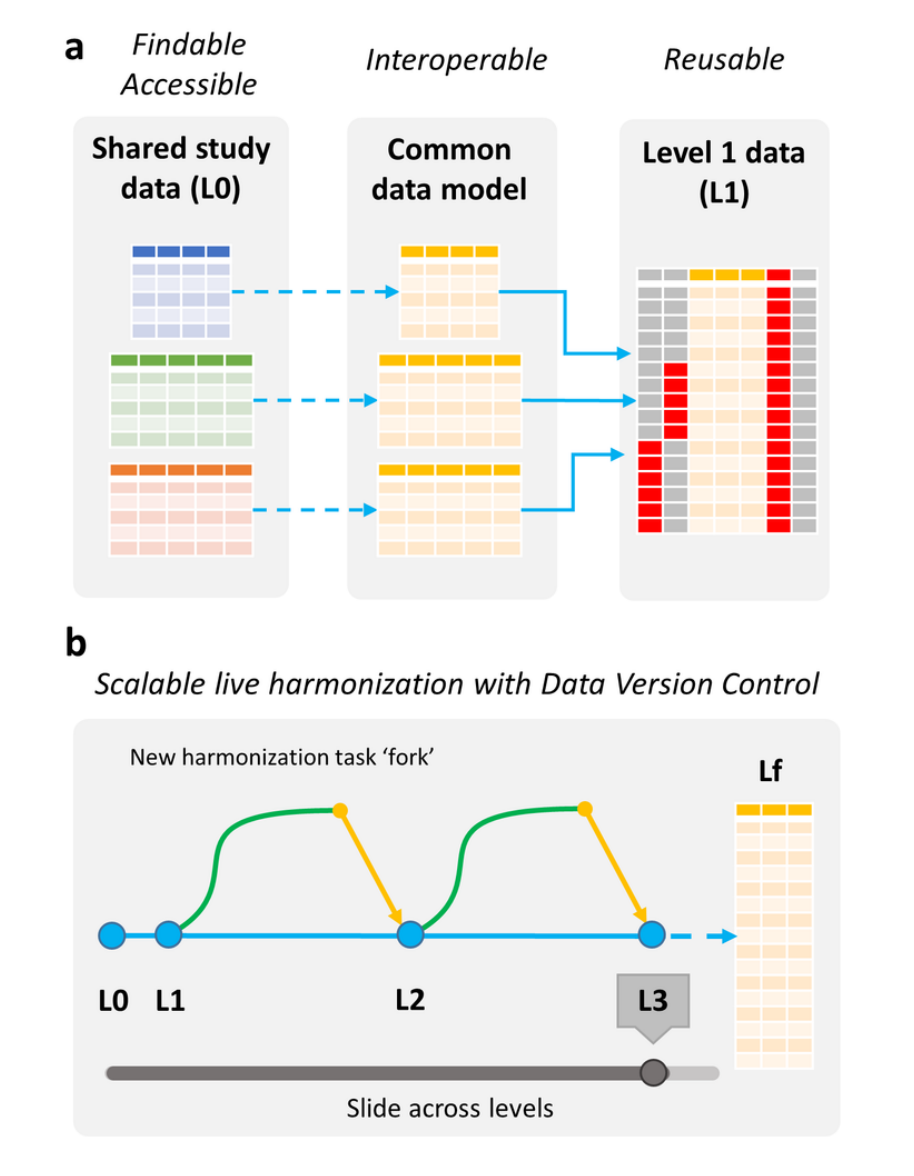
Figure 3. FAIR principles through a live harmonization. Adopting FAIR improves harmonization ( a ). Designing studies for interoperability reduces the cost and time of data formatting to a common model, and using common vocabulary during data collection ensures higher alignment and reusability of the data sets. Harmonization through data version control ( b ). It is possible to traverse or slide across levels of harmonization from raw data to fully harmonized derivative data sets. The data lifecycle from the point of collection through to analysis can be viewed in a version control context as a series of ‘forks’ in data harmonization as data are readied for reuse in a diverse set of pooled analysis